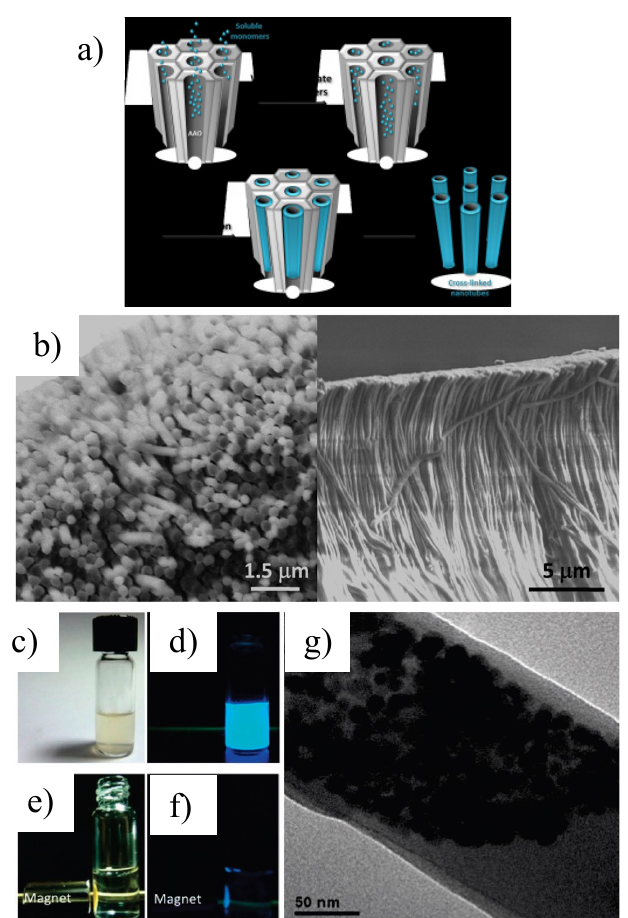
Figure 5. ( a ) Scheme of preparation of poly ‐ VB ‐ FNPD nanotubes in AAO ‐ templated in situ polymerization. ( b ) SEM images of the array of poly ‐ VB ‐ FNPD nanotubes. ( c ) The Fe 3 O 4 NP–OLET nanocomposites dispersed in DI water. ( d ) The corresponding blue emission excited using a 365 nm